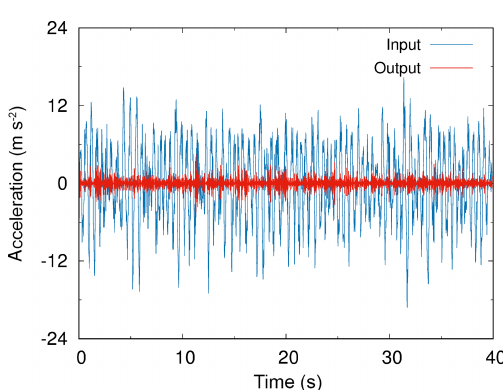
Figure 10. First four mode shapes.